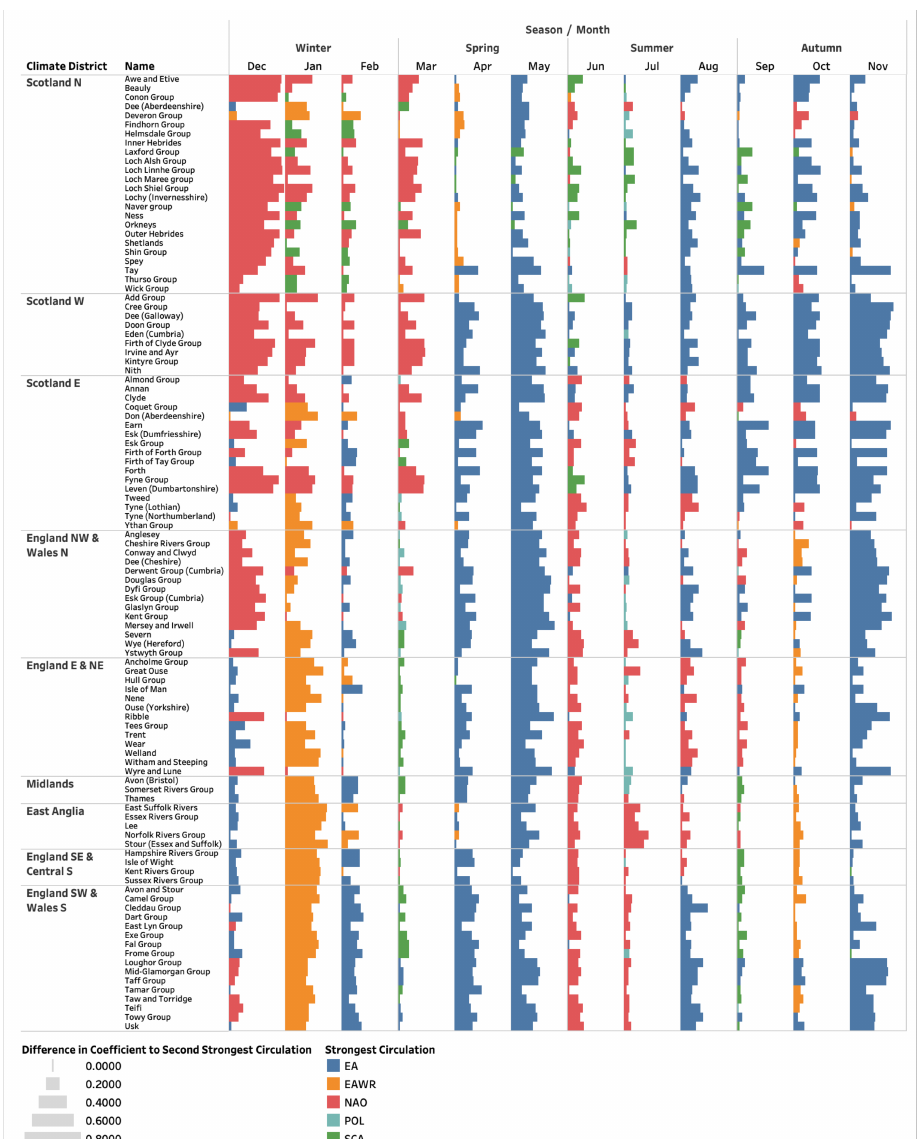
Figure 11. The strongest standardised coefficient values from Figures 5–9. Colour indicates which circulation is the most influential in the multivariate regression (i.e., the circulation with the strongest absolute SC value). The size of the bar is based on the difference in absolute SC between the dominant and second most influential